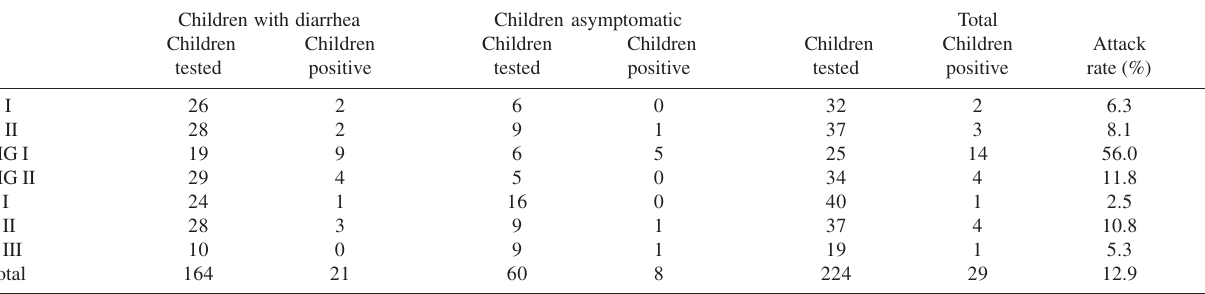
Table 2 - Distribution of laboratory positive results for Cryptosporidium confirmed by PCR and collected from children with symptoms of intestinal disease and asymptomatic children by classes - diarrhea outbreak in daycare at the Clinical Hospital, Sao Paulo Brazil, March-May